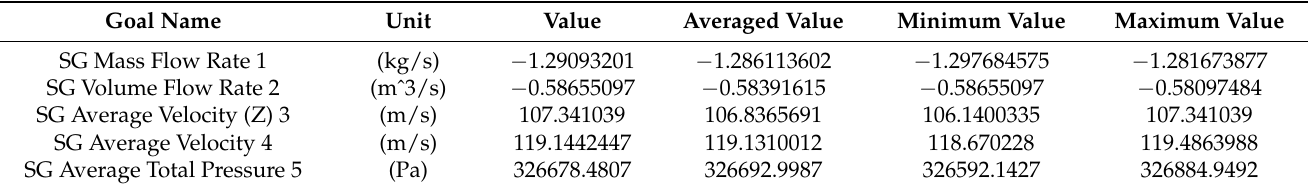
Table 3. Numerical results of mass and volume flow rate for the compressor outflow (Figure 9).